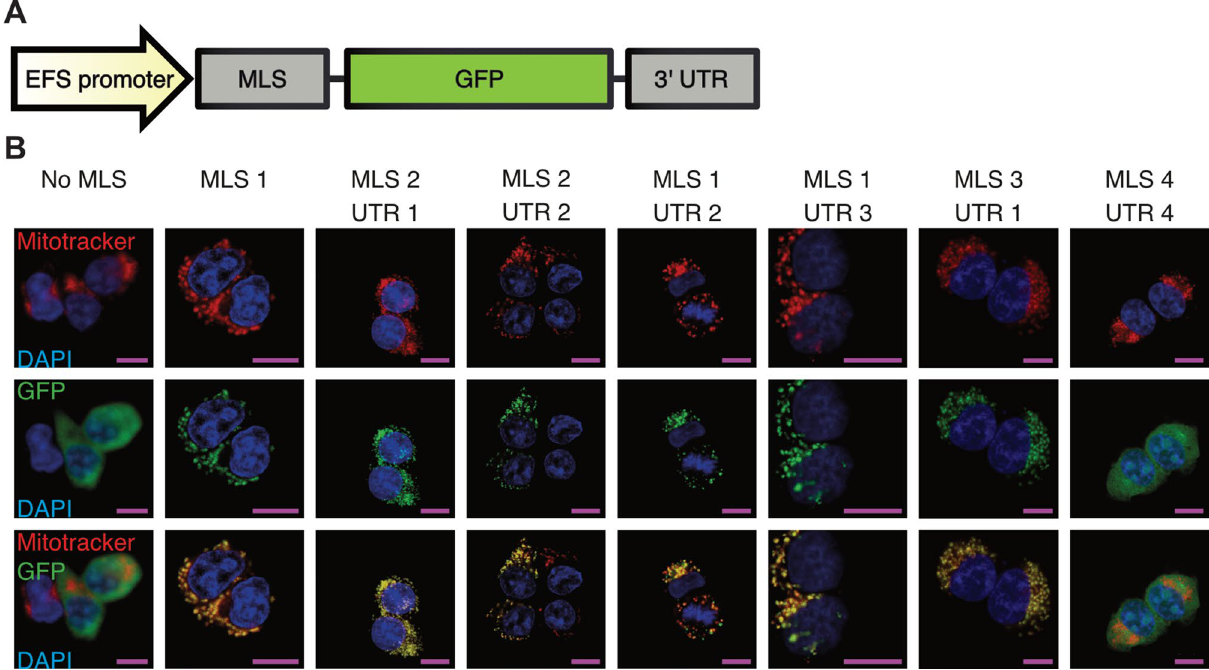
Figure 1. Import of GFP into mitochondria of HEK 293T cells. ( A ) Different MLS/UTR combinations were attached to GFP to facilitate import into mitochondria. ( B ) Representative images showing HEK 293T cells transfected with different constructs. GFP is shown in green, DAPI in blue, and Mitotracker CMXRos in red. Most MLS/UTR combinations lead to clear colocalization of GFP and mitochondria. Scale bars: 10